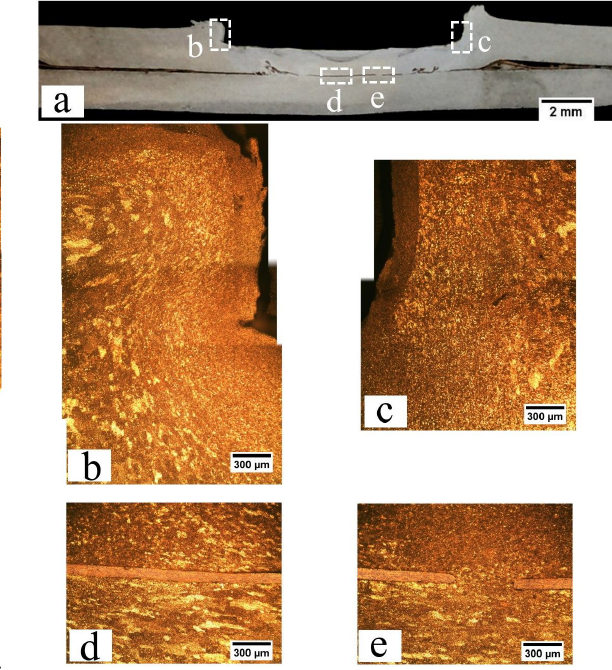
Figure 6: Metallurgical characterisation of weld cross-section with Cu interlayer (W15 P-FSSW joint): (a) macrostructure of joints, (b) transition zone in the AS, (c) transition zone in the RS and (d, e) interface in the centre of